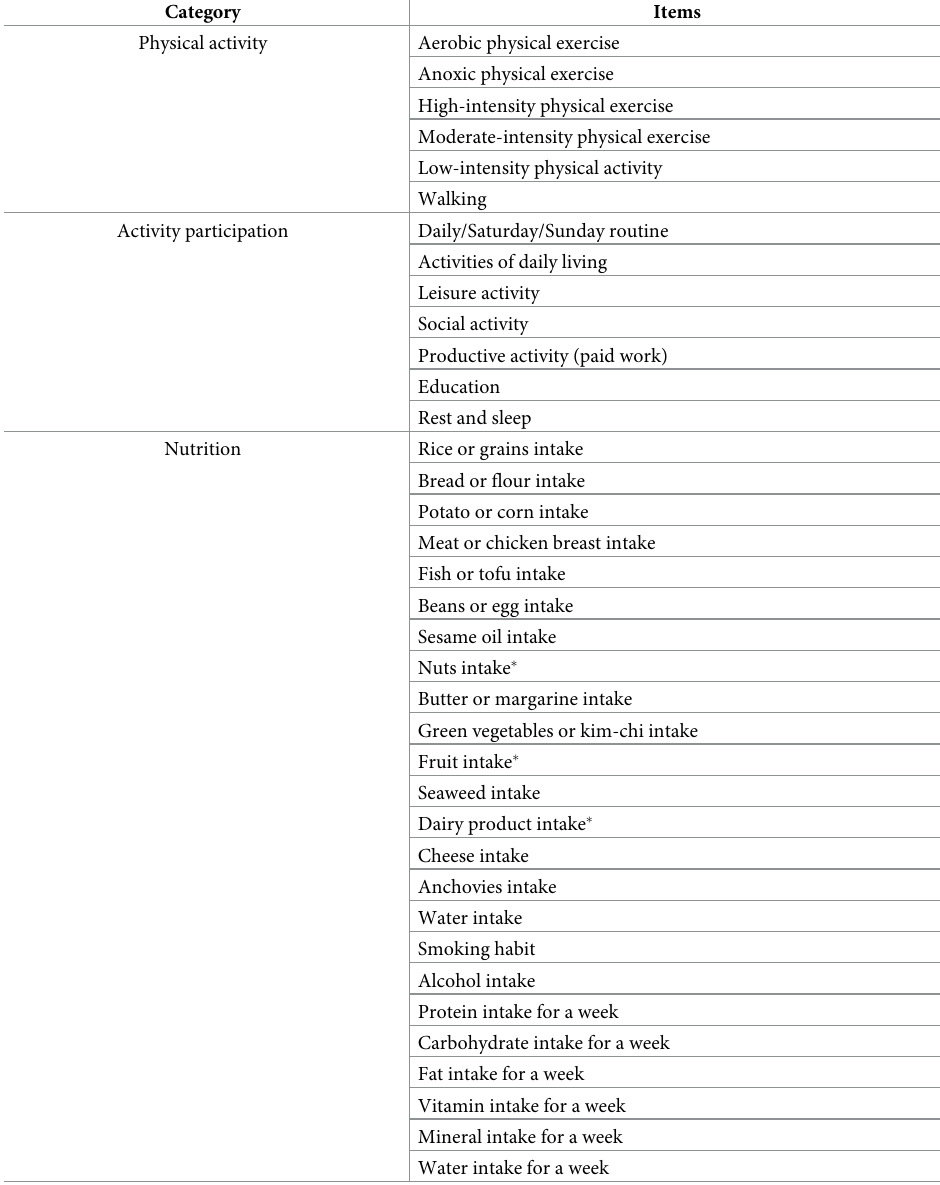
Table 3. Categories and items of first Delphi